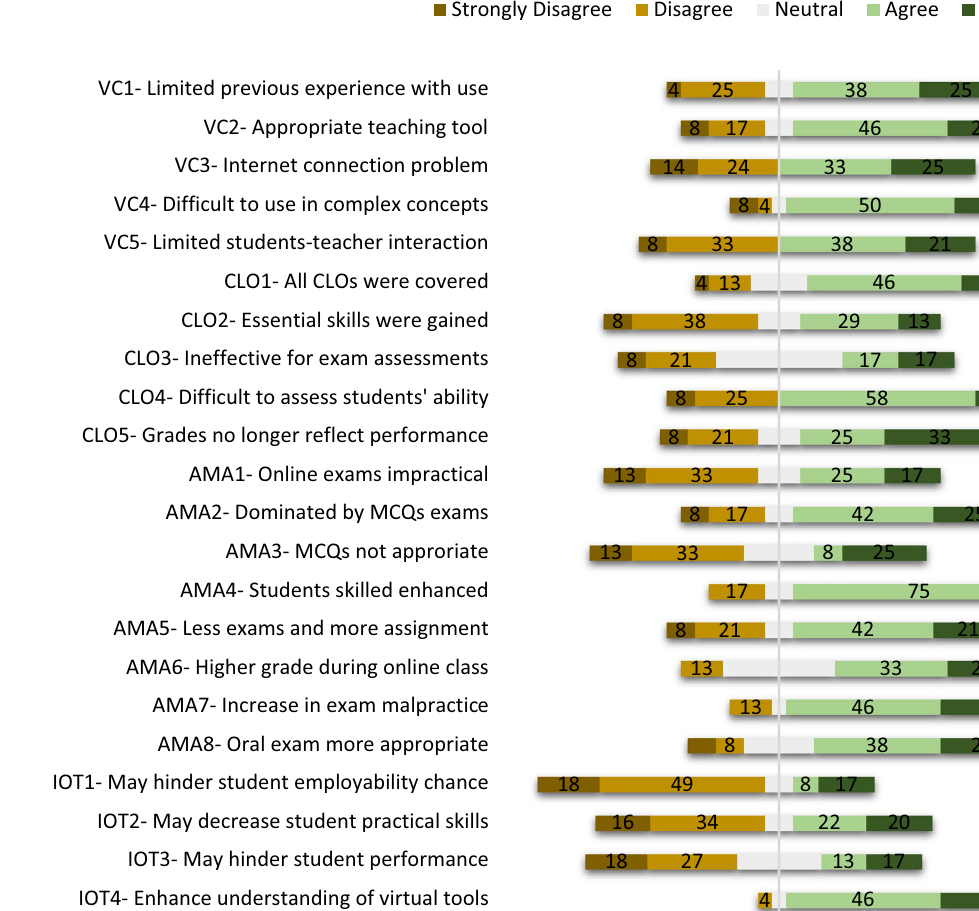
Fig. 2 Diverging stacked bar chart showing results in percentage (%) from the five-point Likert scale teacher-targeted questionnaire ( n Responses were collected in four categories: virtual classrooms (VC), course learning outcomes (CLO), alternative method of assessment (AMA) and impact of online teaching (IOT). The complete statements from the questionnaire are available in Additional file 1: Table